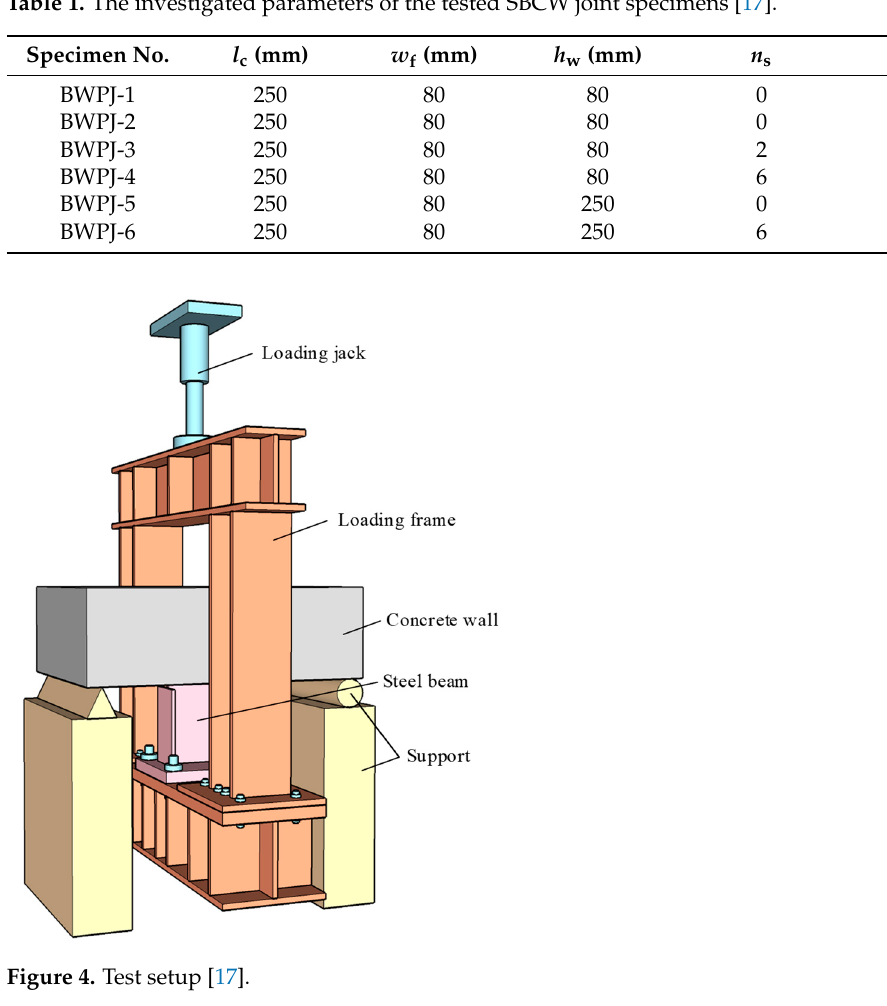
Figure 4. Test setup [17].